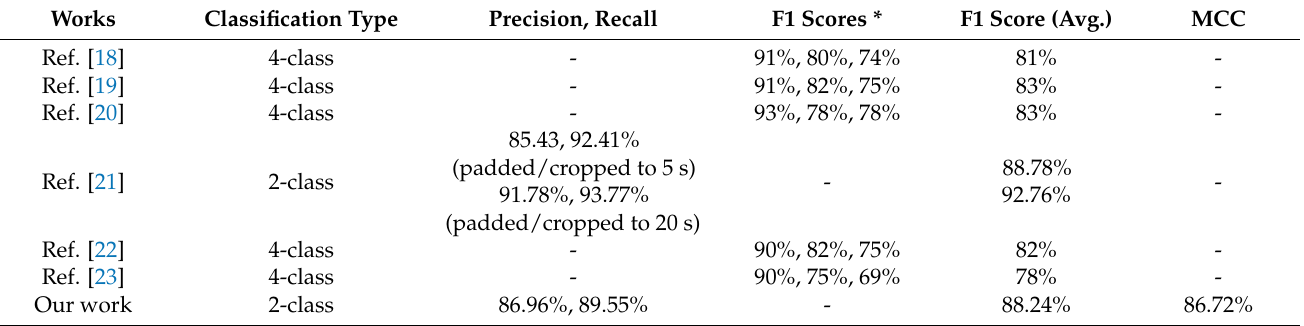
Table 7. Performance of our model in comparison with existing classifiers (- denotes not